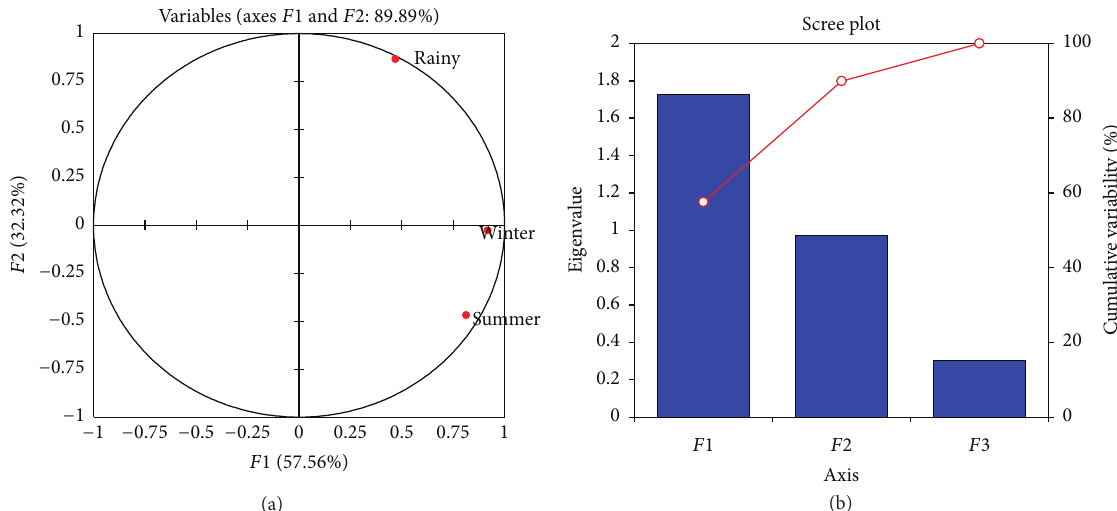
Figure 3: PCA showing (a) the relationship in the distribution pattern of Bacillus spp. and (b) Scree plot of the factors extracted.